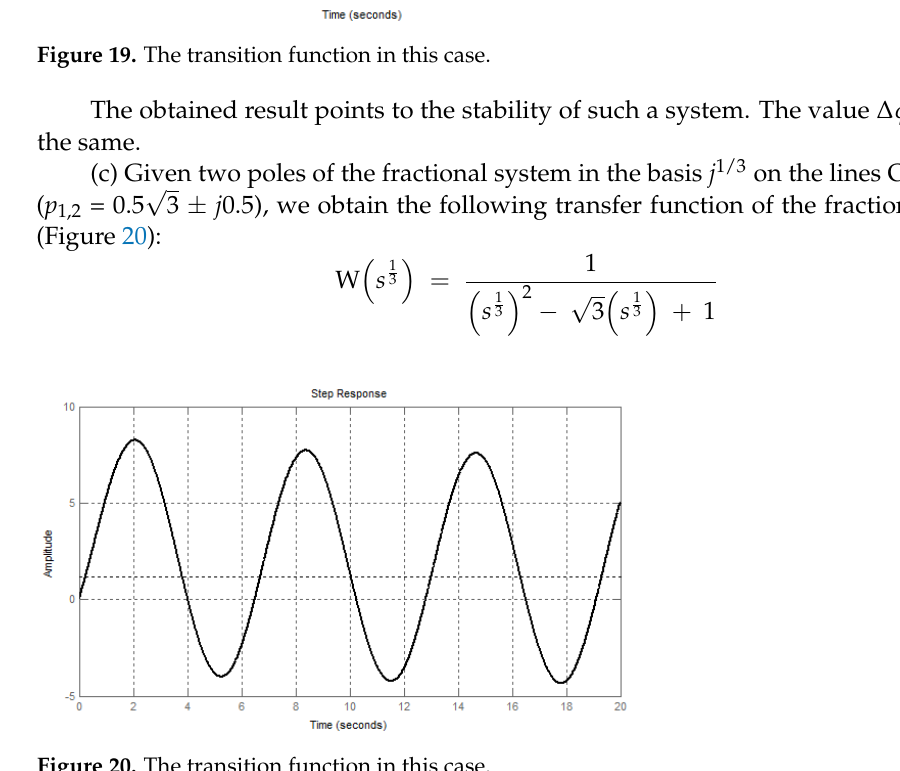
Figure 20. The transition function in this case.